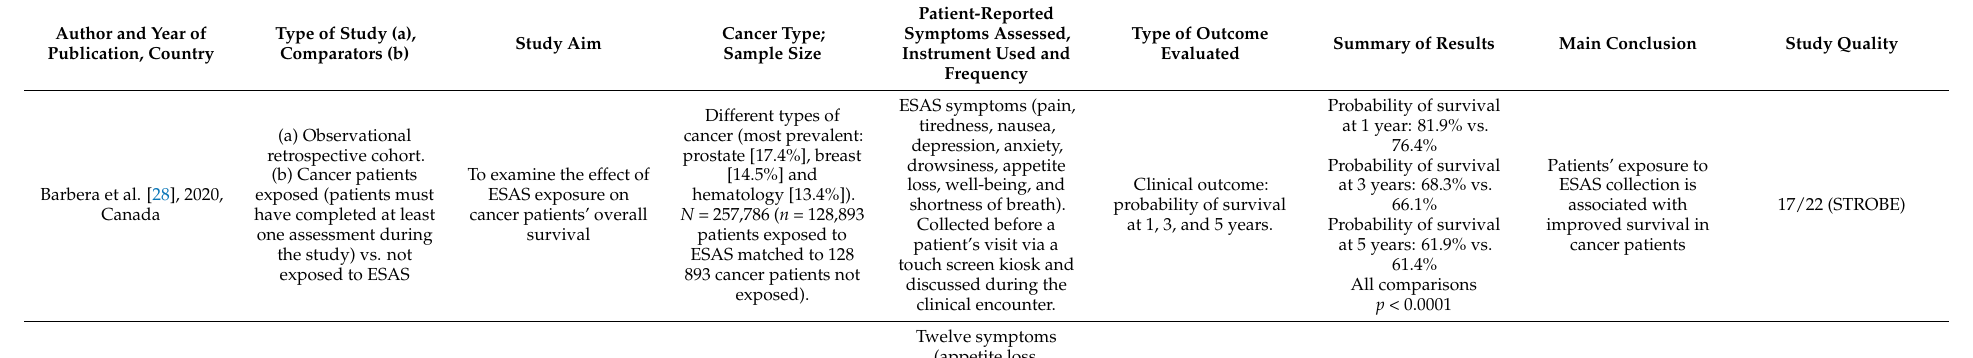
Table 2. Summary of the identified